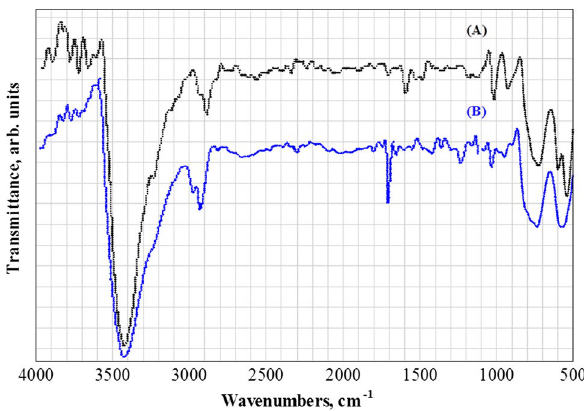
Fig. 5 a , b FTIR of TiO 2 /Al 2 O 3 thin films before and after photo- catalytic degradation of